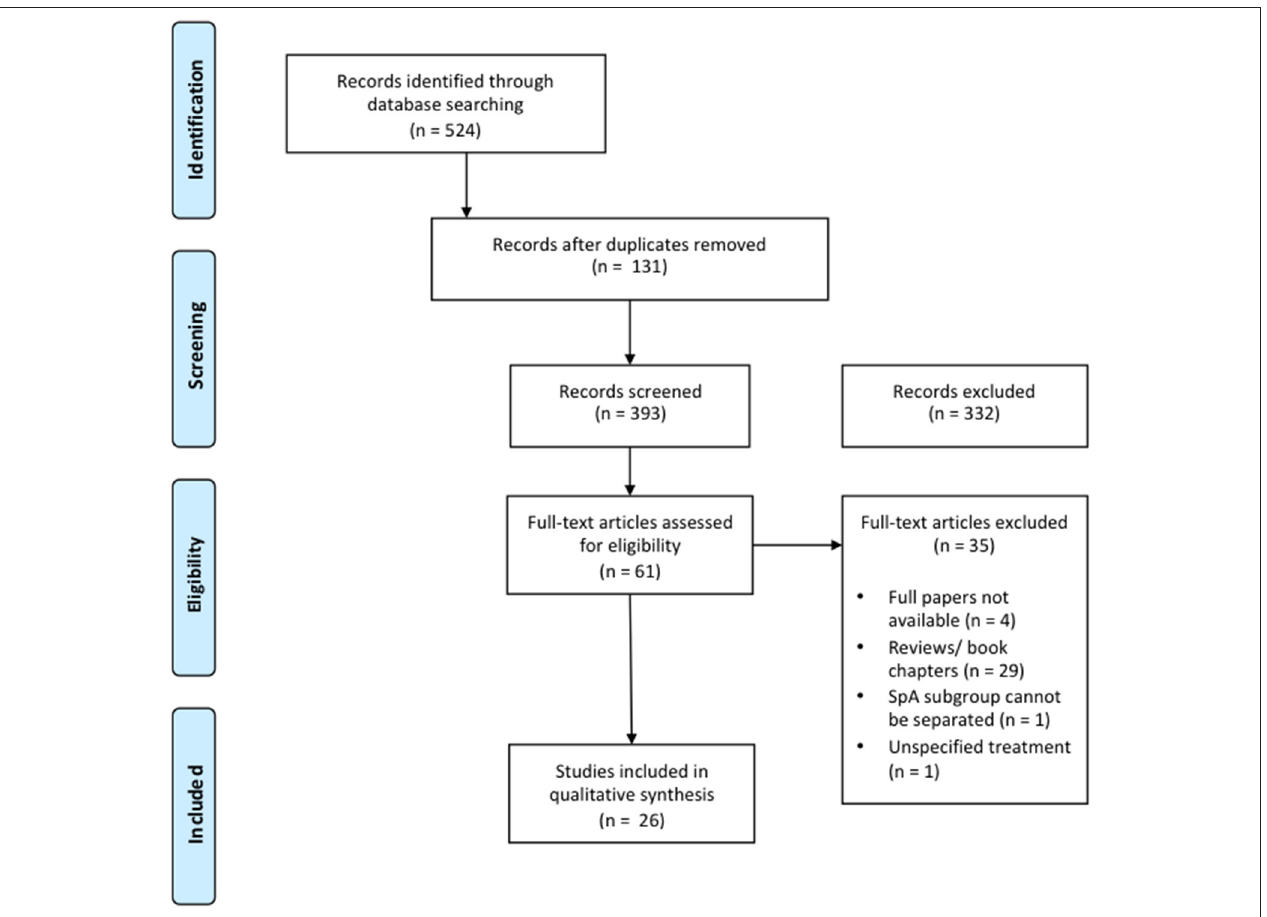
FIGURE 1 | PRISMA flow diagram of studies’